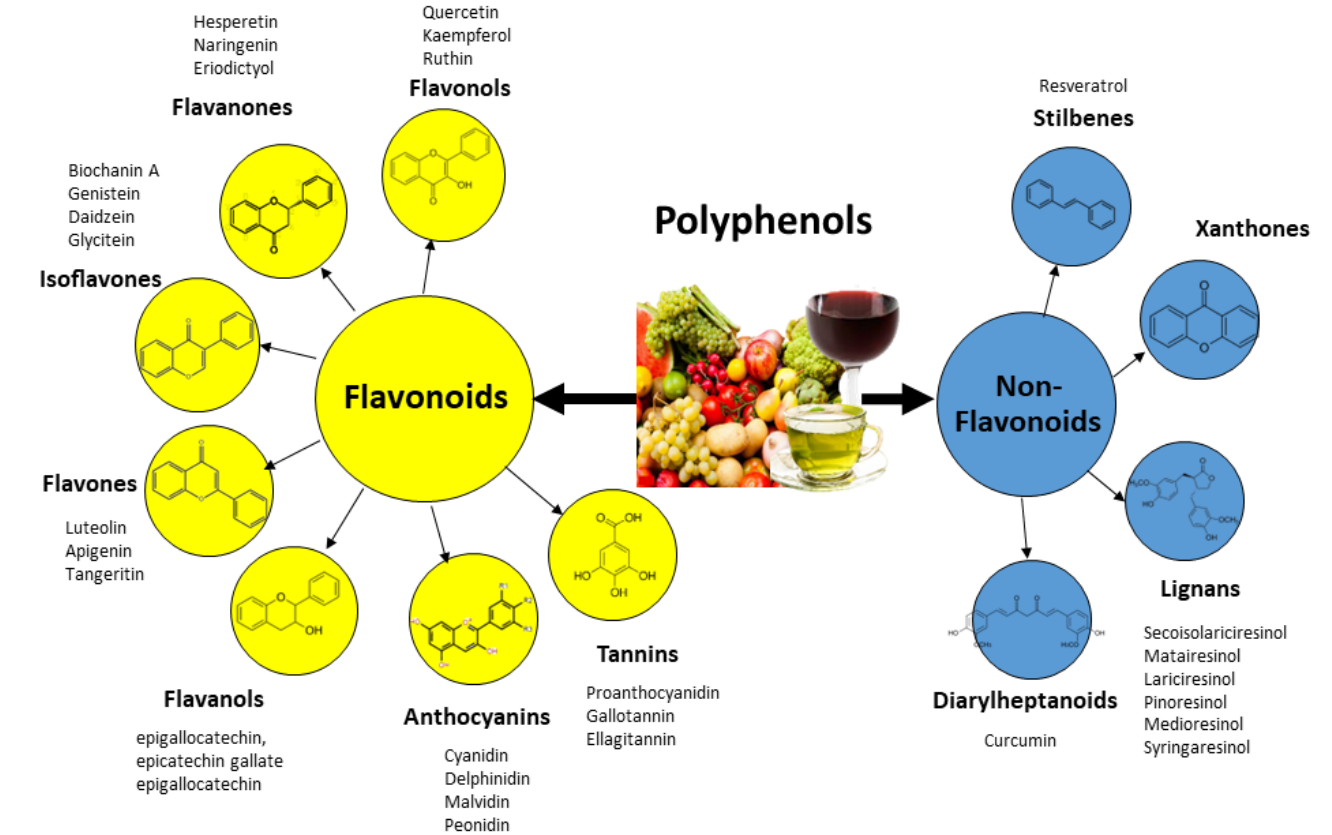
Figure 1. Polyphenol classes, chemical structures, and main compounds.